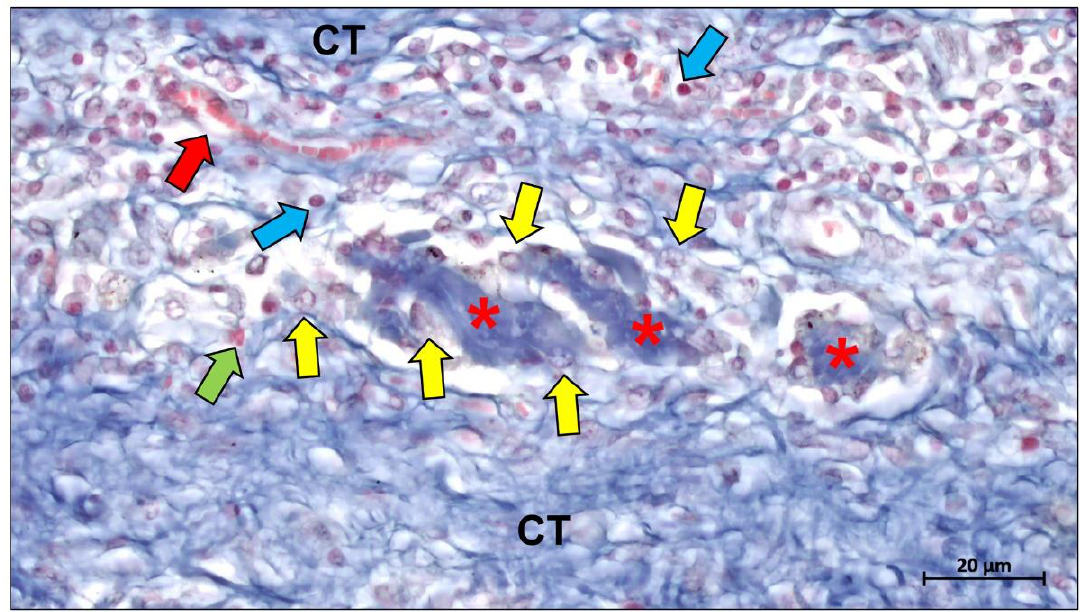
Figure 6. Representative histological image showing the fast biodegradation of a native dermis- derived collagen material (red asterisks = material remnants) within the subcutaneous connective tissue (CT) at day 15 post implantationem. Yellow arrows = macrophages, blue arrows = lymphocytes, green arrow = eosinophilic granulocyte, red arrow = blood vessel (Masson Goldner staining, 400× magnification, scalebar = 20 µm).